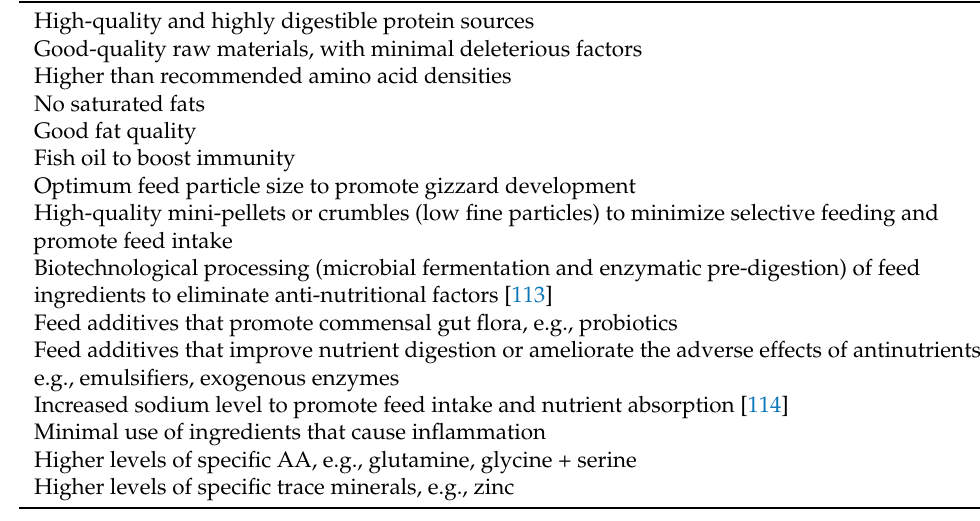
Table 5. Some aspects for consideration in the formulation and manufacturing of special pre-starter